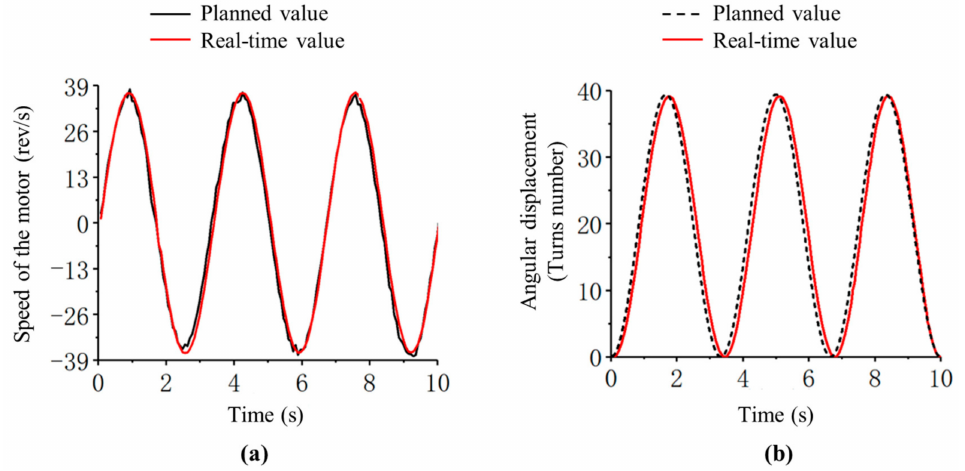
Figure 14. Variation of the ( a ) speed and ( b ) angular displacement in the load